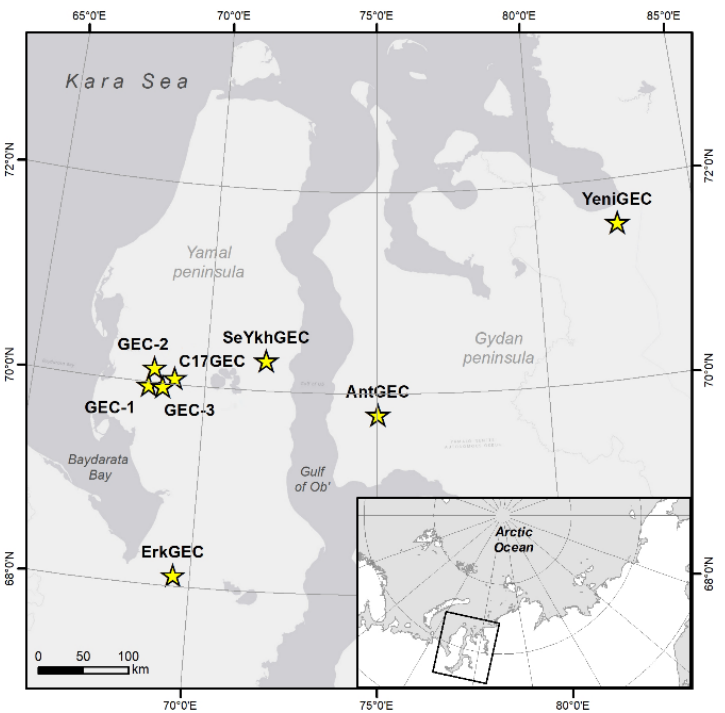
Figure 1. Location of gas-emission craters (marked by stars) in the north of the Western Siberia. GEC-2 is located 20 km north of GEC-1 and 10 km south of the Bovanenkovo field. V.I. Bogoyavlensky showed that in the place of the lake in 2009–2010 there was a large heaving mound with a diameter of ~60 m. In 2013, in its place, there was already a reservoir with a size of 100 × 60 m and a depth of up to 6 m, around which there were more than 35 small and rounded lakes with diameters of up to 8 m and with shafts of ejected soil [4]. GEC-3 was discovered 1.6 km from the Obskaya–Karskaya railway in 2013. Judging by the ridge of the ejected soil and several shallow depressions on the exposed surface from fallen pieces of ejected ice, it can be assumed that gas was released in the summer of 2012 [14]. C-17 GEC , the latest detected crater, was discovered in the Bovanenkovo gas field in 2020. Its structure is similar to the Yamal crater. Here, there is an expanding cavity, where the entrance atop has an elliptical shape of 15 × 18 m, and the bottom also has an elliptical shape of roughly 14 × 60 m. The diameter of the upper part of the crater is 25 m. The depth reaches several tens of meters